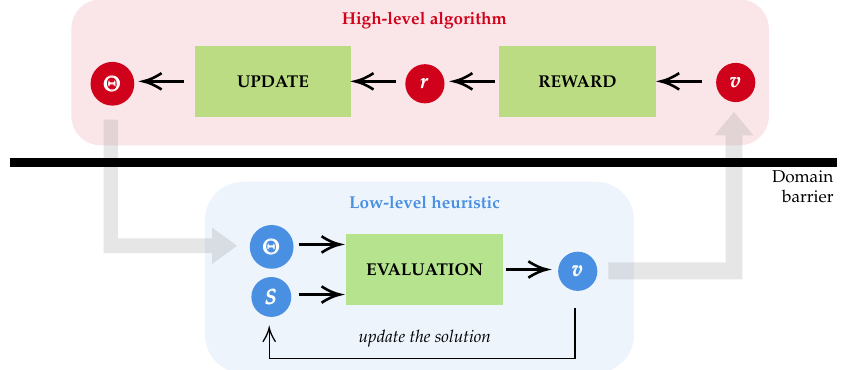
Figure 4. Overview of the proposed QLHH-II